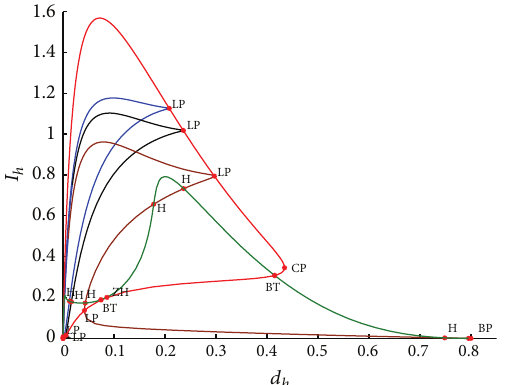
Figure 4: Bifurcation curves in (𝑑 ℎ , 𝐼 ℎ ) plane when 𝑟 = 0.8 , 𝐾 = 10 , = 1 , 𝑎 = 1 , 𝑎 = 0, 0.1, 0.3 , 𝑑 𝛽 1 1 2 = 0.06 , 𝛽 = 0.26 , and 𝑁 𝑝 = 0.007 , 𝑑 V 2